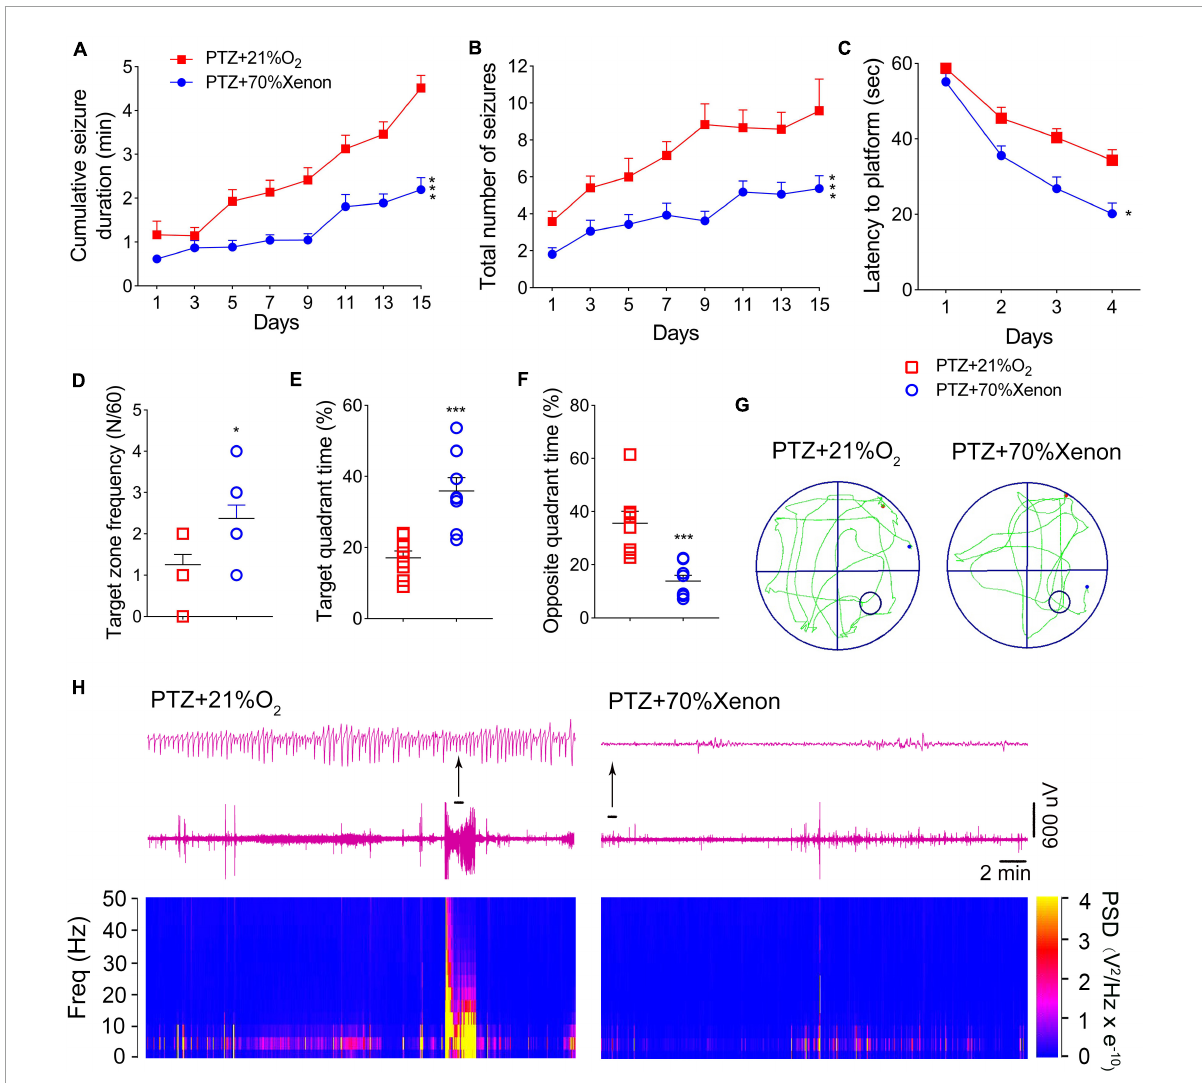
FIGURE5 Xenon treatment reduced severity of pentylenetetrazole (PTZ)-induced epileptogenesis and cognitive deficits. (A) Cumulative seizure duration. (B) Total number of seizures. (C) Latency to the platform. (D) Frequency of platform crossings. (E) Target quadrant time (%). (F) Opposite quadrant time (%). (G) Representative tracking. (H) Representative electroencephalography (EEGs) and power spectrum density. Data are presented as mean ± SEM. * P < 0.05 and *** P < 0.001, compared with controls (panels A–C , two-way RM-ANOVA; panels D–F , unpaired T